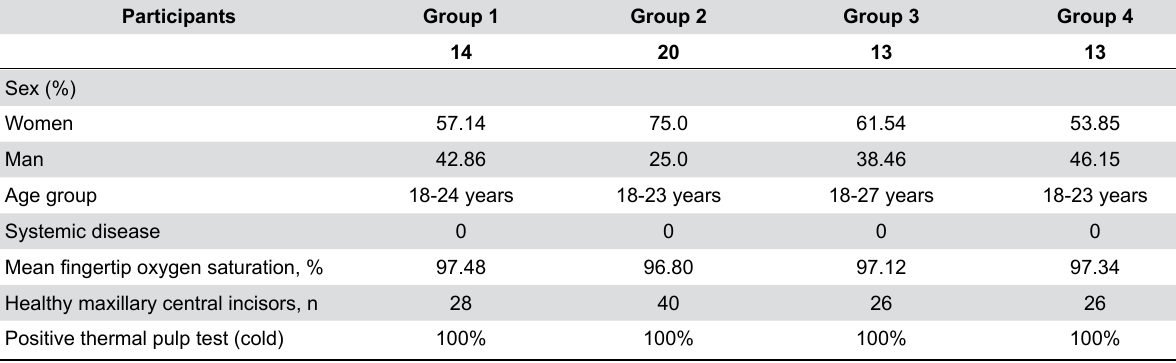
Table 1- Demographic and clinical characteristics of study participants